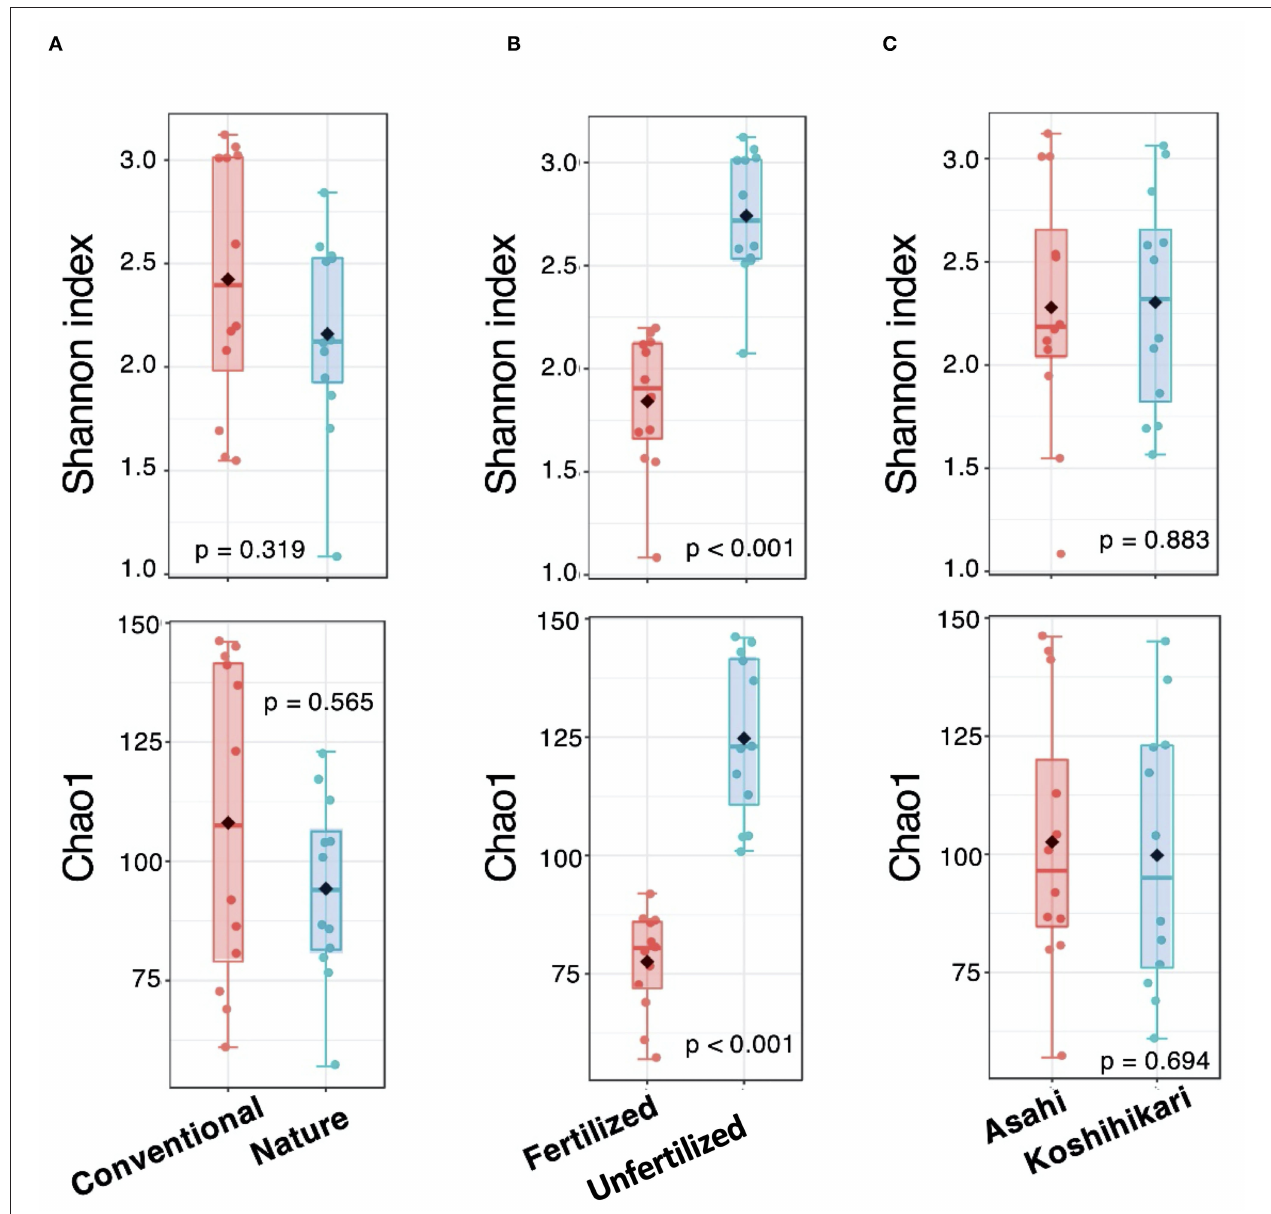
FIGURE 1 | Richness estimators (Chao1) and the diversity index (Shannon) for (A) farming systems, (B) fertilization treatments, and (C) rice cultivar factors.